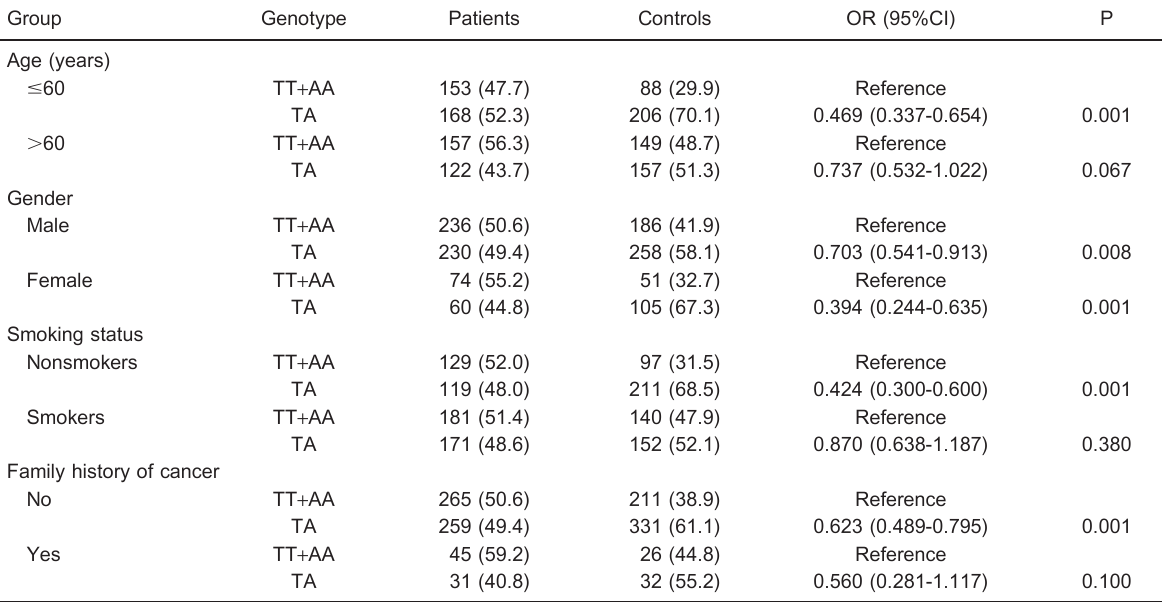
Table 3. Association between genotype frequency and risk of lung cancer.